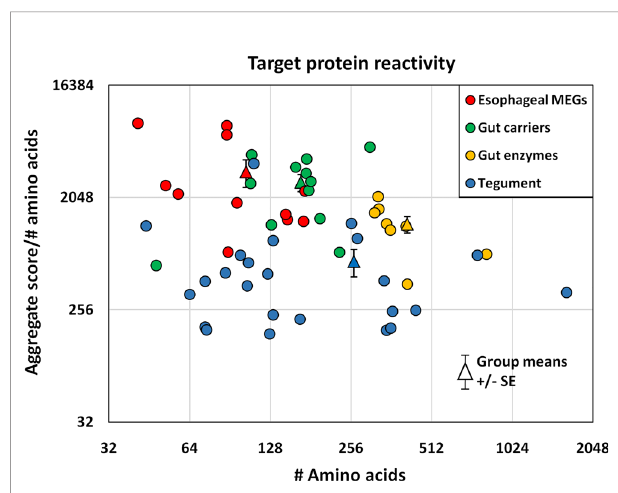
FIGURE 5 | The mean reactivity of array proteins based on the data in Supplementary Table 2 , normalized for number of amino acids and segregated into four groups by tissue of origin. The differences in group reactivity were tested for signi fi cance using a t-test. Note the log y axis